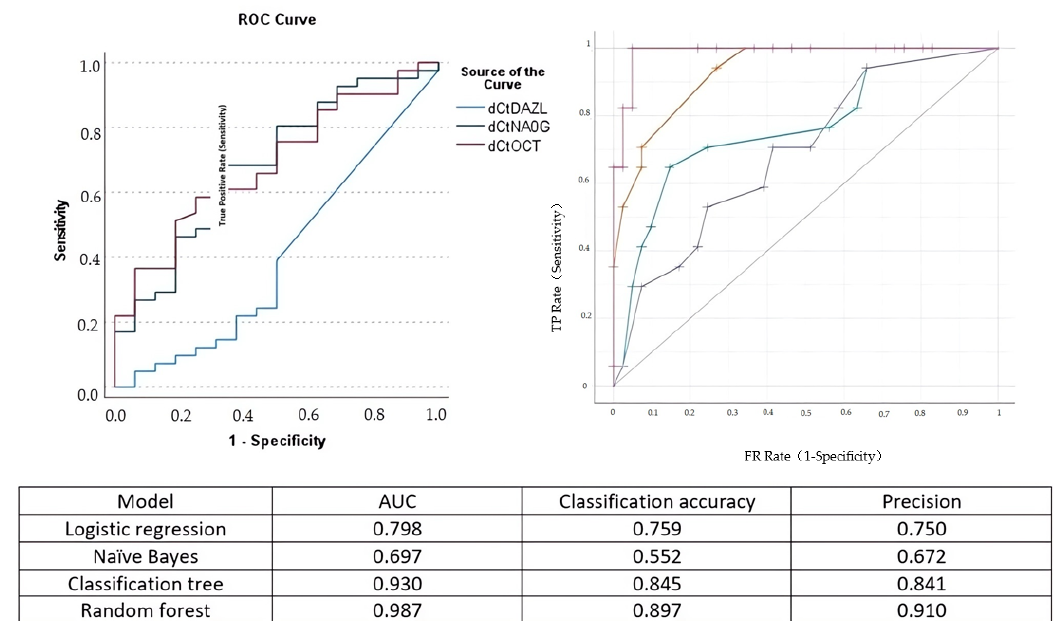
Figure 3. Left side: receiver operating characteristics (ROC) curve for the prediction of cervical insufficiency of DAZL (blue line), Nanog (green line), and OCT-4 (purple line). Right side: ROC analysis of the performance of logistic regression (green curve), naïve Bayes (blue line), classification and regression tree (yellow line), and random forest (purple line) analysis. The model area under the curve (AUC), classification accuracy, and precision are presented in the accompanying Table.